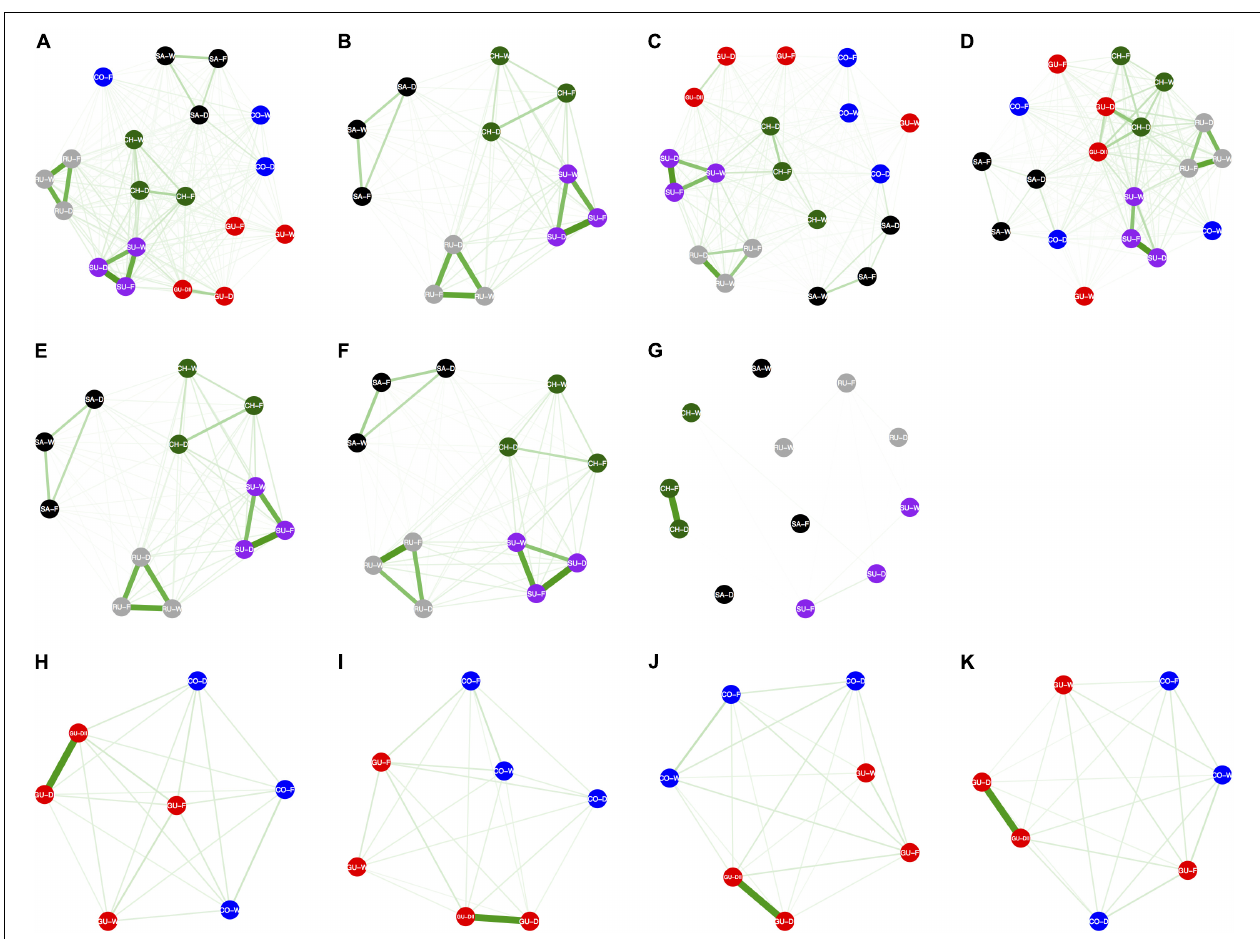
FIGURE 5 | Networks depicting bidirectional gene flow patterns among populations of Espeletia . The width and color intensity of the green lines are proportional to the number of migrants per generation (N e m). The thinnest lines correspond to N e m values below 1. The first row of the diagrams are based on the entire SNP set including all populations (A–D) , while second and third rows only include the datasets for contrasting populations for localities (E–G) and habitats (H–K) , respectively. The first column of the diagrams are based on the entire SNP dataset (A,E,H) , while second, third, and fourth columns only include markers significantly associated with the localities (B,F,I) , the theoretical exposure to frost (C,G,J) and the theoretical soil moisture content (D,K) , as coded in Supplementary Table S1 . The dataset that only includes contrasting populations for localities and markers significantly associated with the theoretical soil moisture content is not shown because lack of polymorphism. Allelic associations of the GBS-derived SNP markers with localities and habitats were quantified using 18 different general and mixed-effects statistical models that accounted for phylogenetic distance. Only results for the optimal models are shown (see details in Supplementary Figure S4 ). Localities and ecotypes are colored and coded as in Figure 1 .